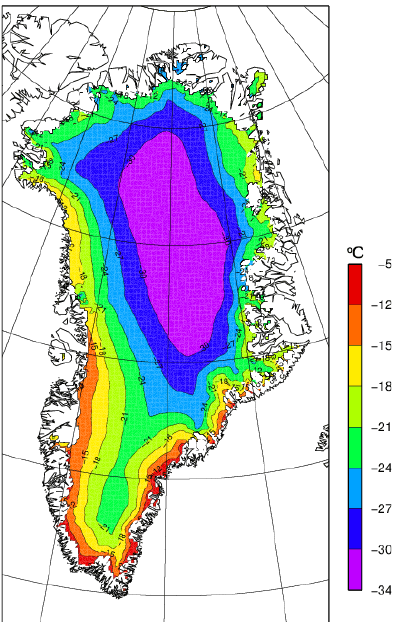
Fig. 4. The period (1958–2008) average annual mean surface tem- perature ( T s ) as modelled in RACMO2. The − 15 ◦ C isotherm cor- responds to an altitude of about 1500m (equilibrium line) in the ablation area on the western margin, and elsewhere ranges from sea level up to 2000m.